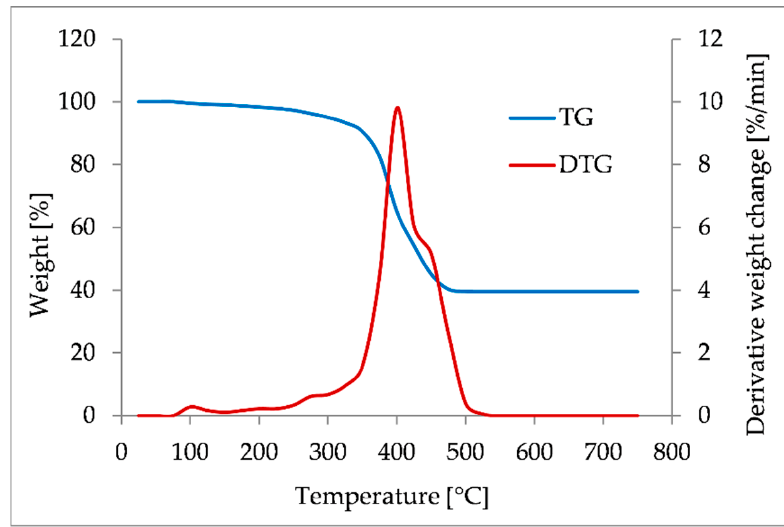
Figure 3. TG and DTG curves of the waste tire.